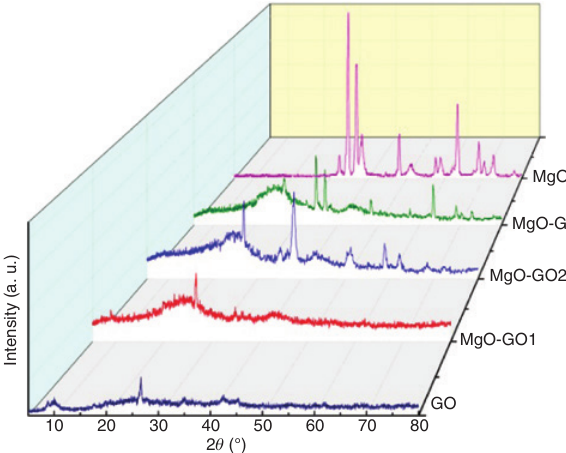
Figure 2: XRD spectra of GO, MgO, and MgO-GO samples.